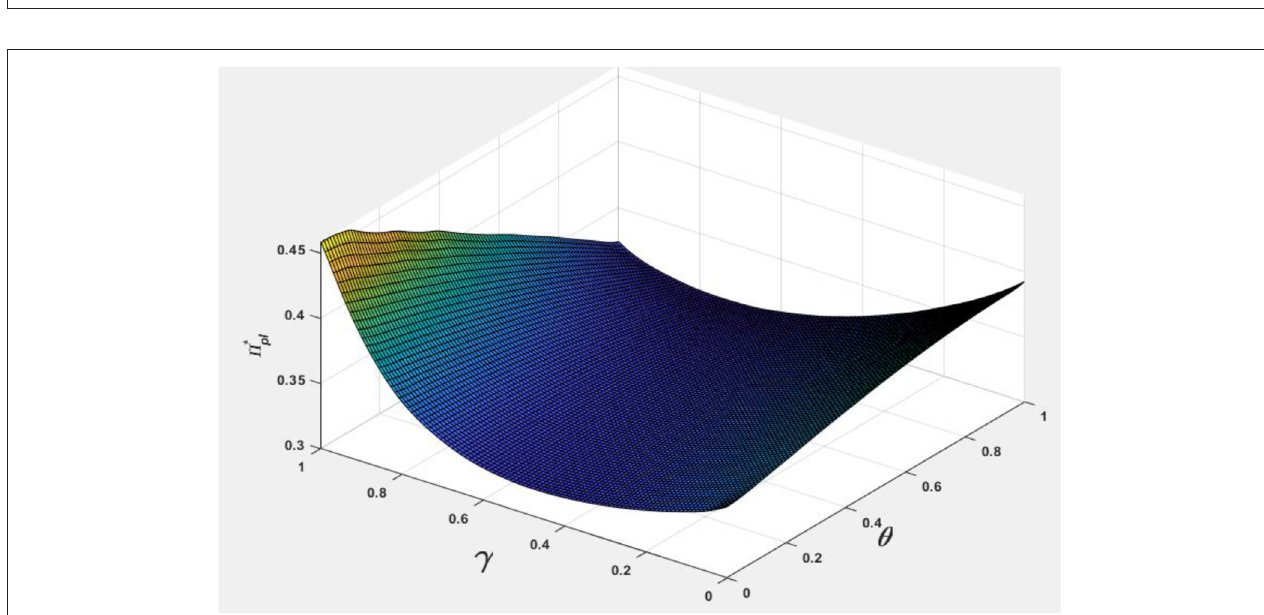
FIGURE 2 | Effect of θ , γ on N * s .